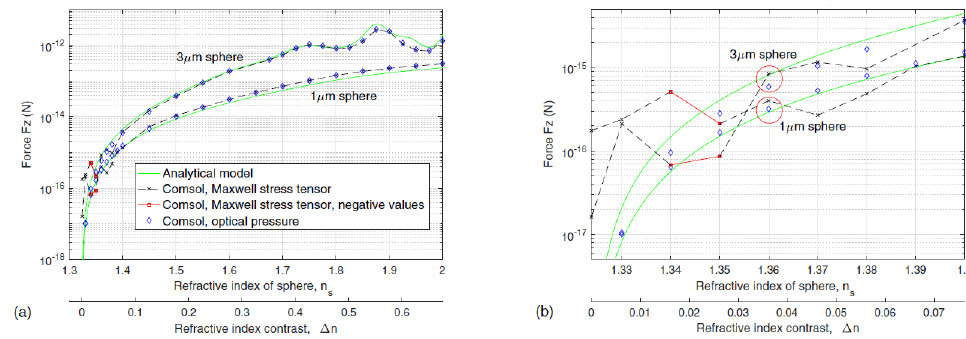
Figure 7. A comparison between MST and optical pressure for simulation: the computation of the radiation force F z on 1 and 3 µ m spheres for ( a ) n water < n s < 2 and ( b ) n s < 1.4, that is, zoom of ( a ). Reprinted with permission from [59] © The Optical